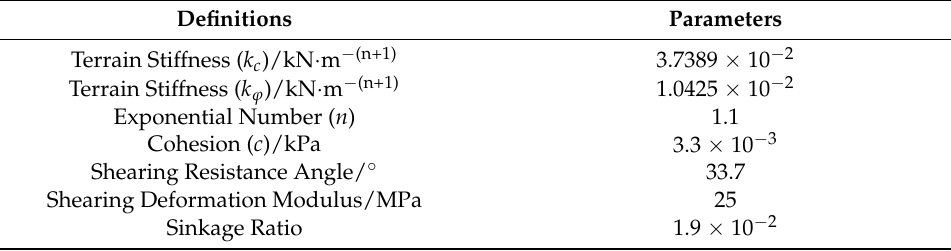
Table 2. Parameters of the soil